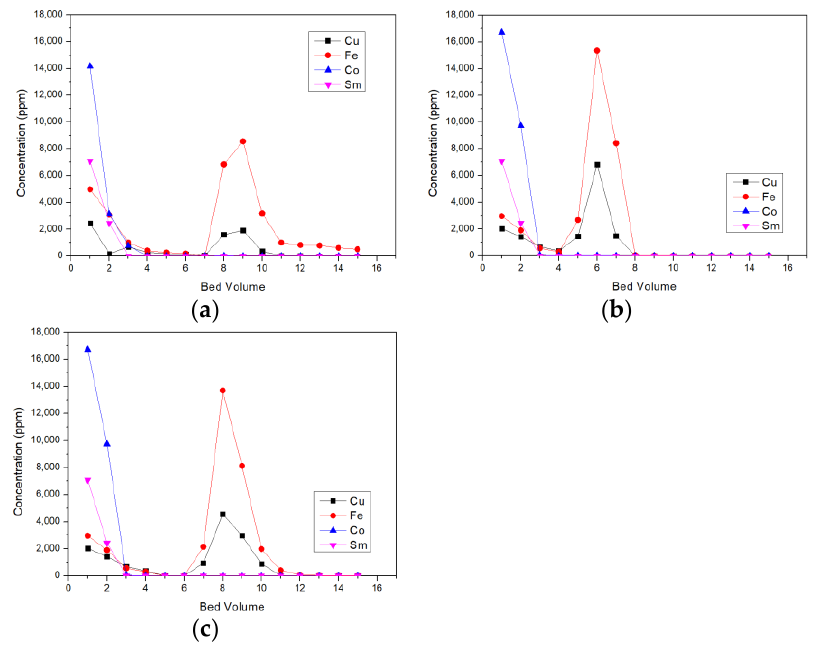
Figure 3. Desorption of Cu, Fe, Co, and Sm at different pH-values (( a ) 1N, ( b ) 2N, ( c ) 3N) using H 2 SO 4 as eluting agent.